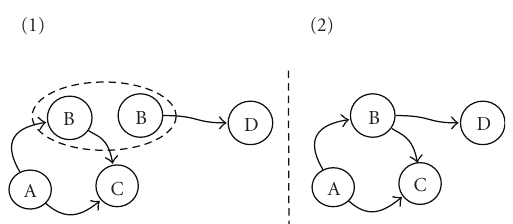
Figure 5: Extension of the state-transition model using the extension-by-unification method.